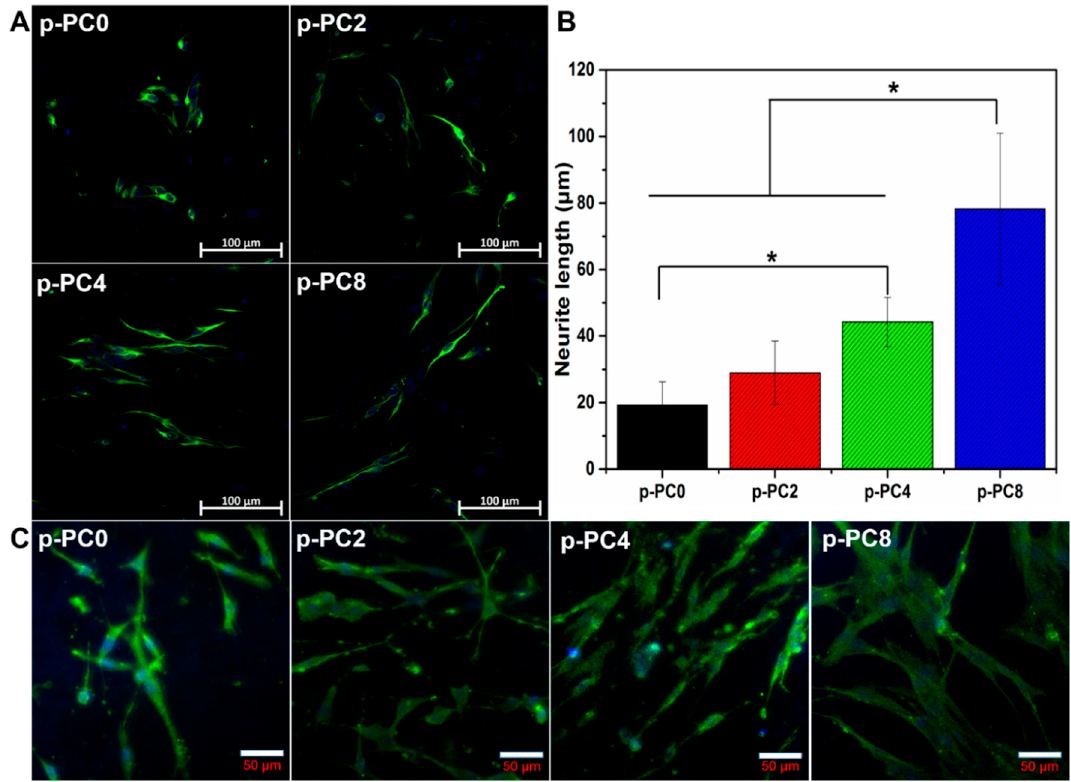
Figure 10. ( A ) LSCM images of rat DRG neurons on different nanofibers after 3 days of culture; ( B ) Neurite length of rat DRG neurons measured with ImageJ software; ( C ) LSCM images of Schwann cells cultured on different nanofibers after 7 days of culture. Green: S100 antibody; Blue: nuclei. Data was mean ± deviation; n =10; * = significant difference at p < 0.05.